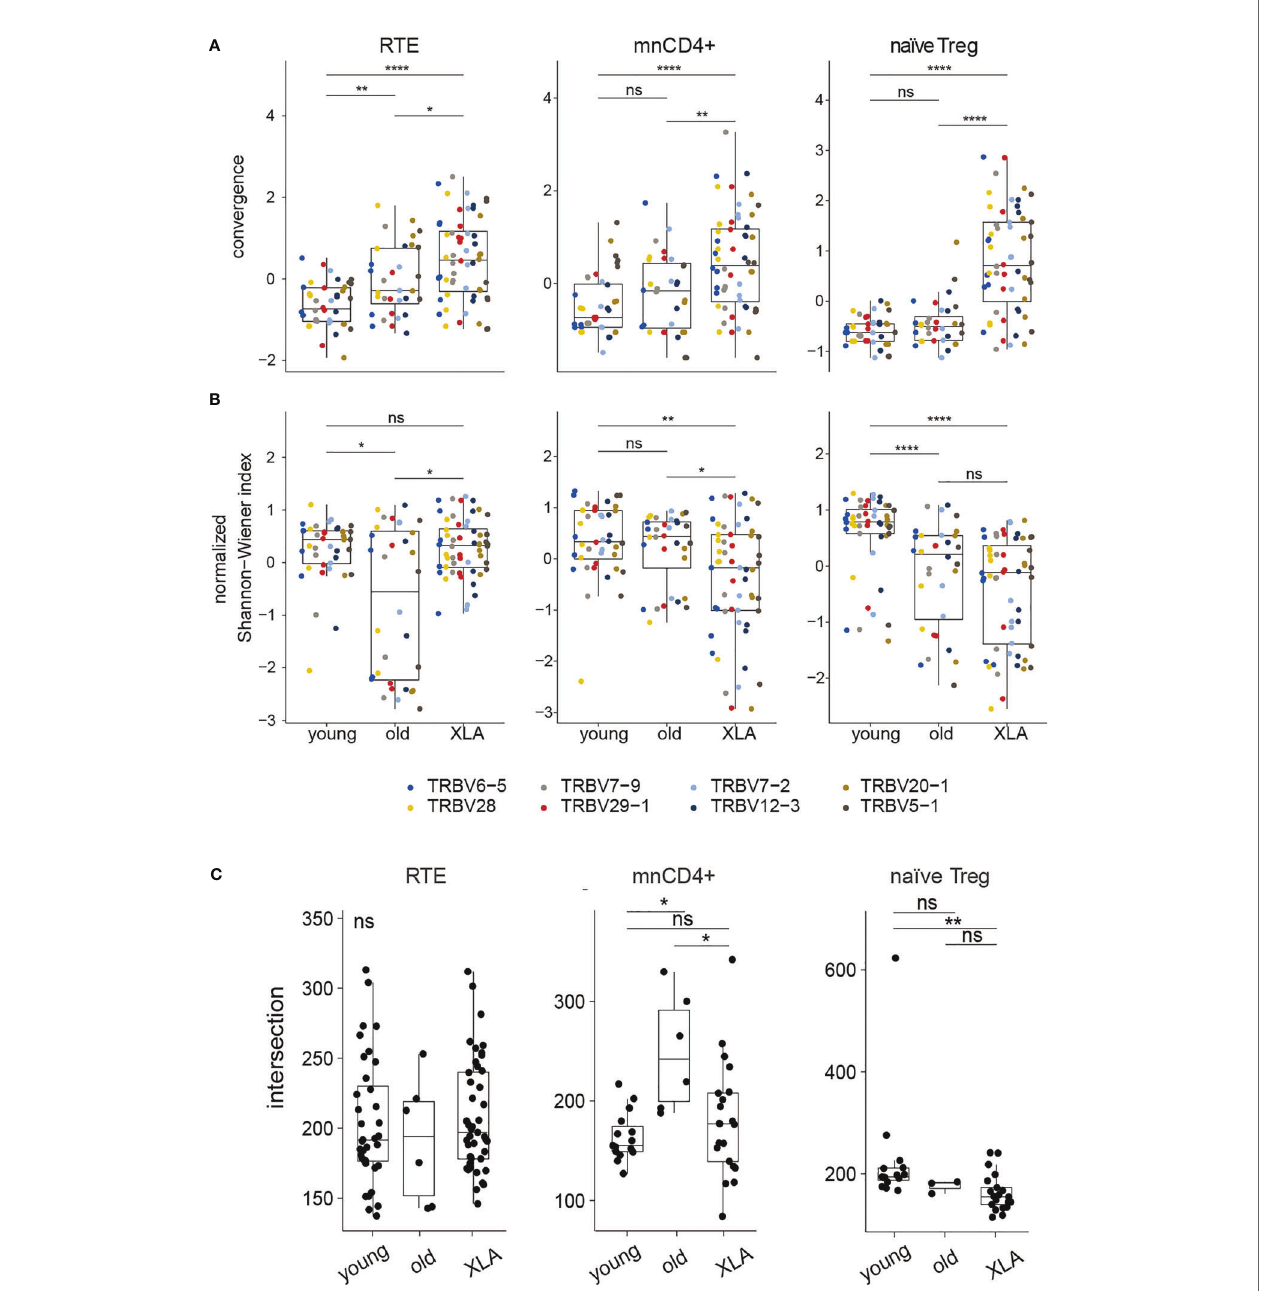
FIGURE 3 | Diversity and convergence of TCR b repertoires of naïve CD4 + subsets in healthy donors and patients with XLA. Analysis of (A) convergence and (B) normalized Shannon-Wiener index in nCD4 + subsets (RTE, mnCD4 + , naïve T reg ) in young and old healthy donors and in young XLA patients. Values were obtained for highly abundant TRBV gene segment groups and normalized to mean deviation. For the RTEs, the top 1,524 UMI-labelled sequences were analyzed for every TRBV segment. Donors Y13 and X10 were excluded because of insuf fi cient coverage; this analysis included 8 young healthy donors, 4 old healthy donors, and 6 XLA donors. For the mnCD4 + , 1,063 UMI -labelled sequences were analyzed for every TRBV segment. Donors Y8, Y13, and X10 were excluded, and this analysis included 7 young healthy donors, 4 old healthy donors, and 6 XLA donors. For T reg , 953 UMI-labelled sequences were analyzed for every TRBV segment. Donors X8, X9, X10, Y8, Y10, Y11 were excluded due to insuf fi cient coverage, and this analysis included 6 young healthy donors, 4 old healthy donors, and 4 XLA donors. Signi fi cance of median differences was evaluated by Dunn test. The false discovery rate was controlled using the Benjamini-Hochberg adjustment. *p < 0.05, **p < 0.01, ****p < 0.0001, ns, non signi fi cant. (C) Shows the number of shared public clonotypes between pairs of samples based on CDR3 amino acid sequences, from the 13,000 most abundant clonotypes in each cell subpopulation (for young donors, N = 9 for RTE and mnCD4 + , and N = 6 for naïve T reg ; for old donors, N = 4 for RTE and mnCD4 + , and N = 3 for naïve T reg ; for XLA patients, N = 10 for RTE and mnCD4 + , and N = 7 for naïve T reg ). All samples were down-sampled to the same number of UMIs (23,000 mnCD4 + , 24,000 RTE, 31,000 naïve T reg ). NS, non signi fi